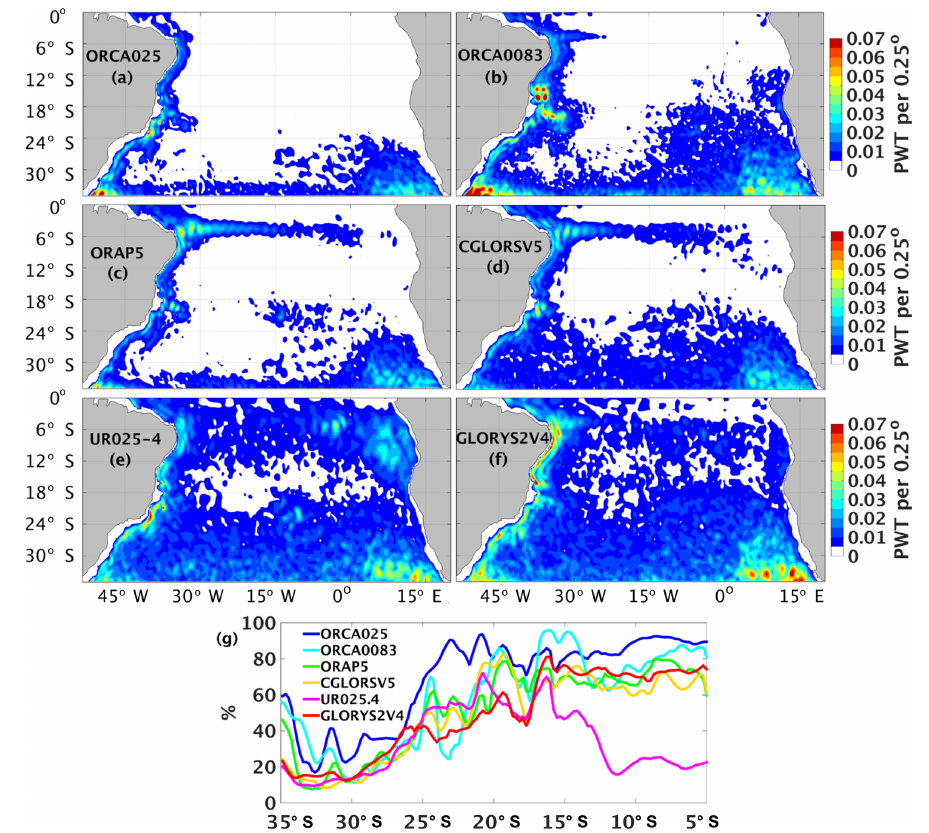
Figure 12. (a–f) Inter-annual p _OTT spread for the period 1997–2010. Units are in PWT per 0.25 ◦ . (g) The inter-annual p _OTT variances for each product are summed within 6 ◦ of the west coast across each latitude and displayed as a percentage of the total MHT variance.